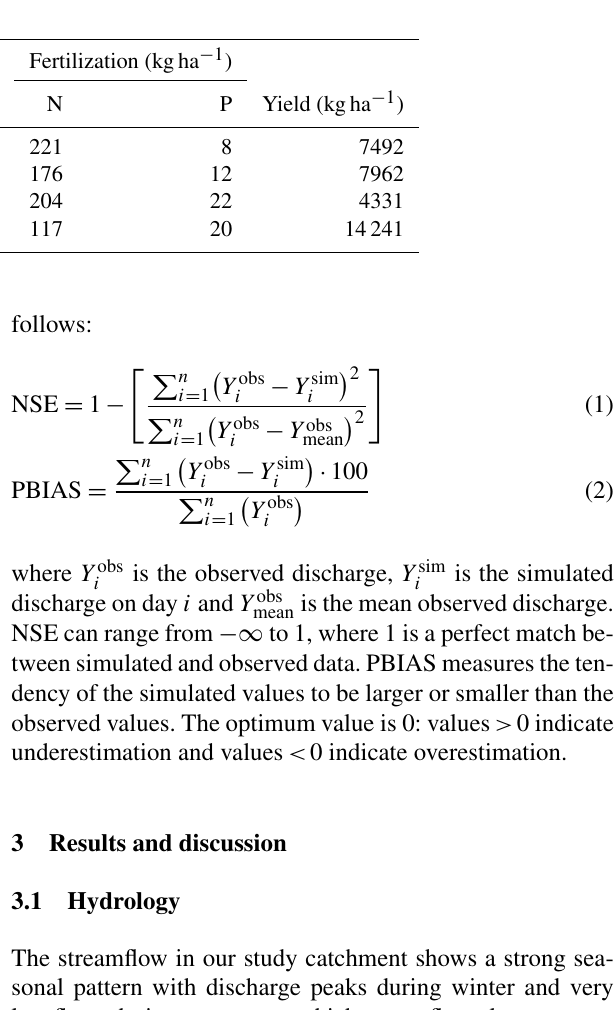
Table 1. Cultivated arable crops and crop management including average seeding/harvesting dates, fertilizer application and yields. The yield is given as dry